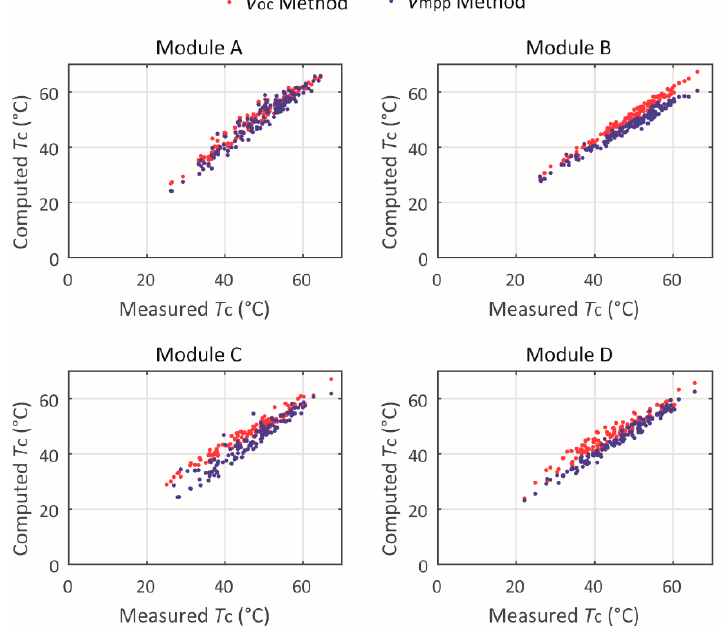
Figure 3. Temperature correlation by open-circuit voltage V oc method [35] and maximum power point V mpp method [34].